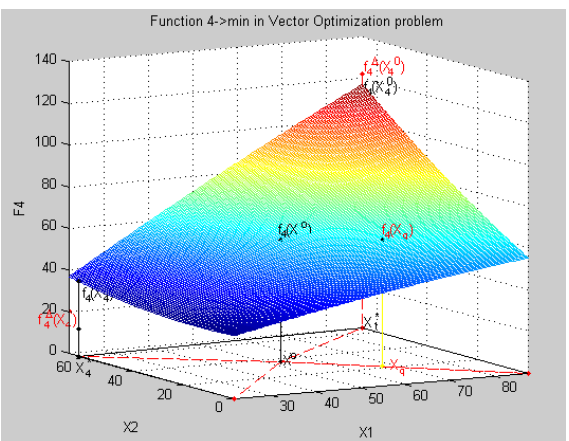
Figure 19. The fourth characteristic f3(X) of the system in a natural indicator.